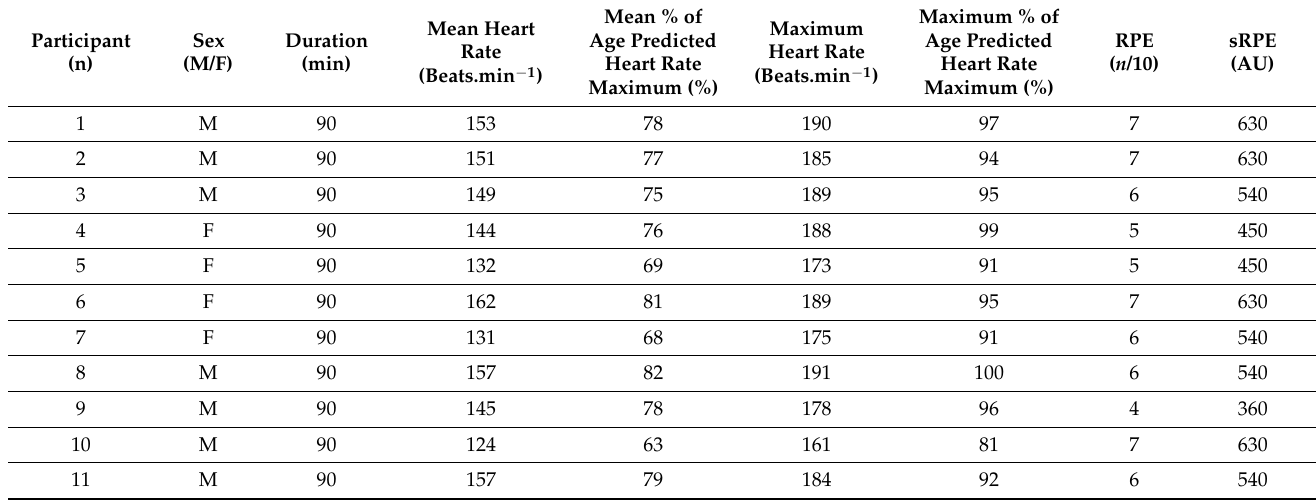
Table 1 conveys the training load of each player throughout the training session. Table 1. Player’s training load throughout the training session.